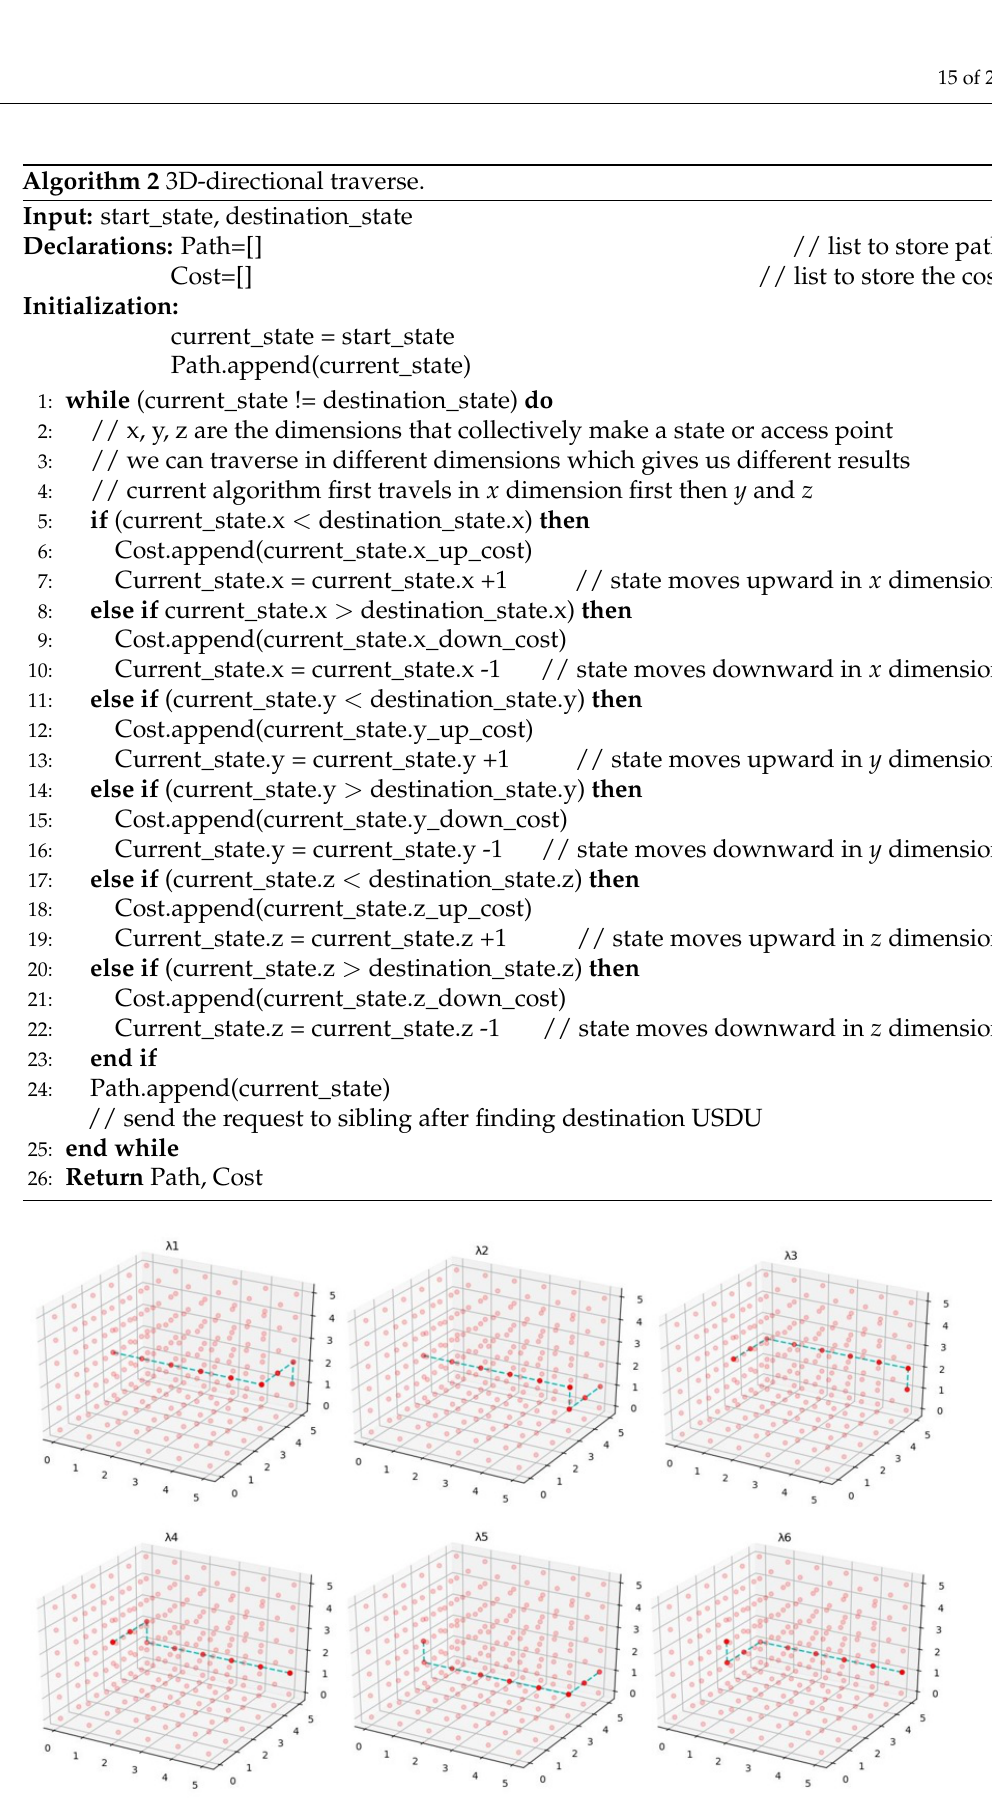
Figure 11. Possible combinations of paths from one state to other particular